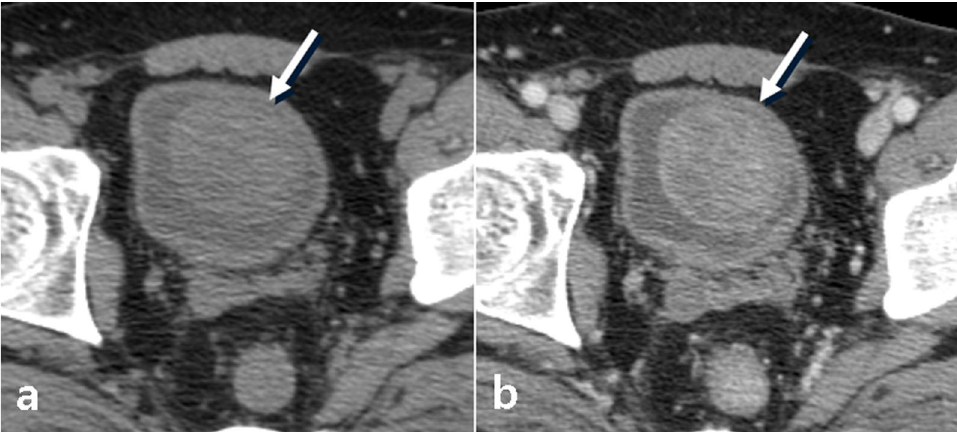
Fig. 13 A 49‑year‑old male patient with a solitary fibrous tumor of the bladder. Axial pre‑contrast ( a ) and post‑contrast ( b ) CT images showing a large well‑circumscribed solid enhancing mass (arrow) in the